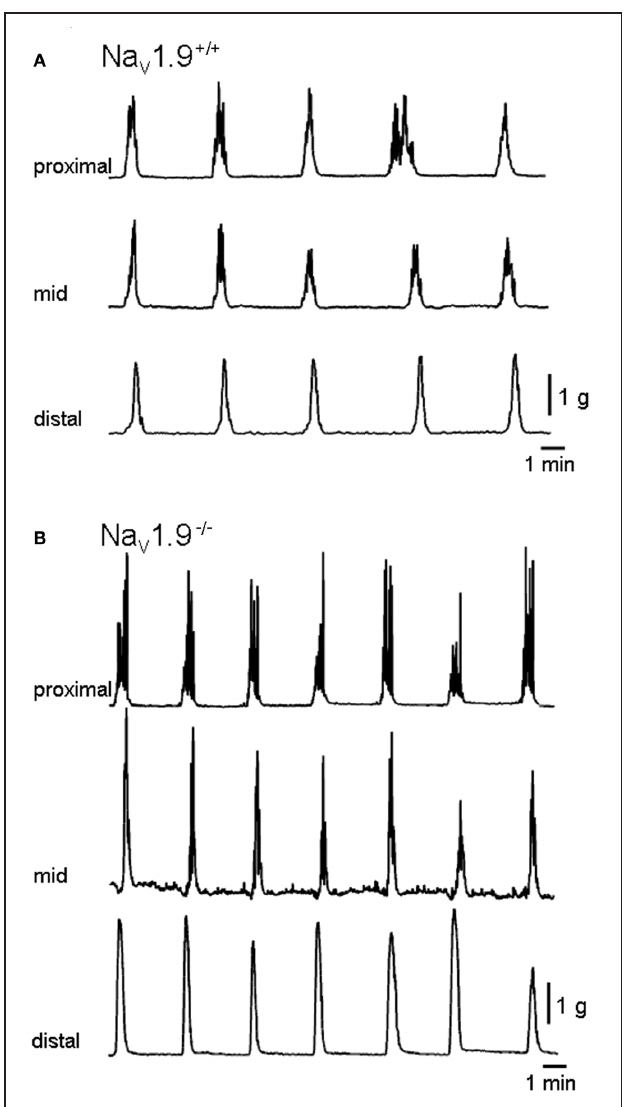
FIGURE 2 | Mechanical recordings made simultaneously from three sites of the colon. (A) and (B) are typical traces of migrating motor complexes in the colon (CMMCs) of wild ( + / + ) and Na v 1.9 − / − mice, respectively. In Na v 1.9 − / − mice, the interval between CMMCs and their duration were shorter and the area higher than in wild-type mice.